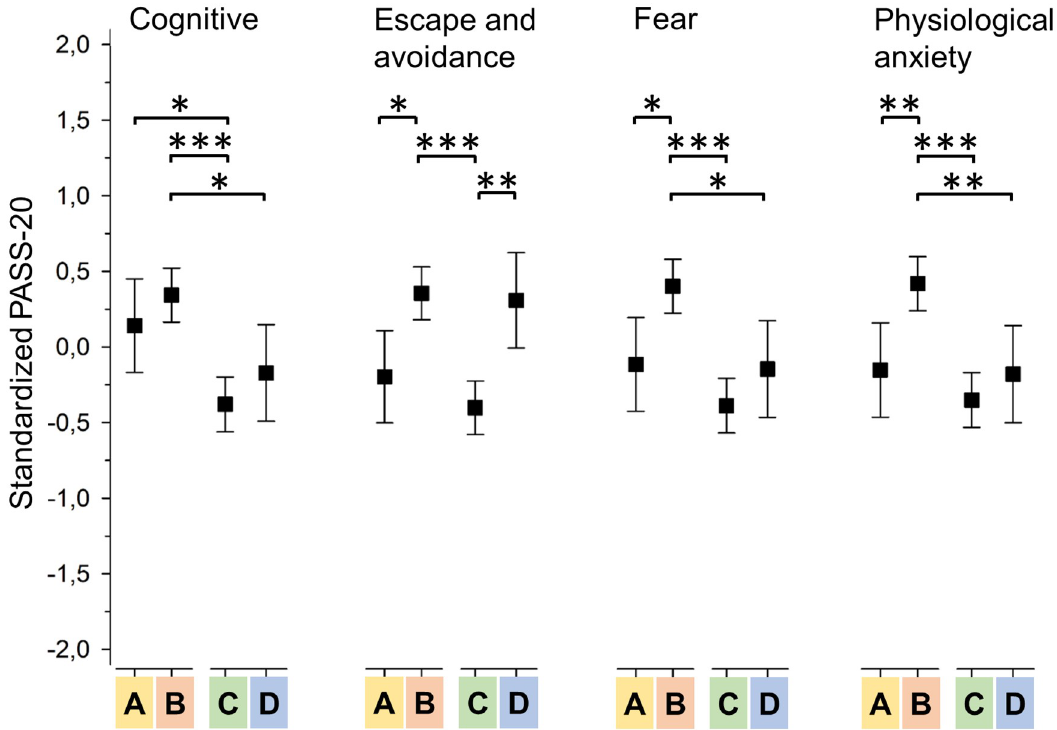
Fig 3. Standardized Pain Anxiety Symptoms Scale (PASS-20) subscale means with respect to different interference groups. A = activity low, affective high; B = activity high, affective high; C = activity low, affective low; D = activity high, affective low. Asterisks denote significant group differences: � = P < 0.05; �� = P < 0.01; ��� = P < 0.001. Box plot whiskers represent 95% confidence